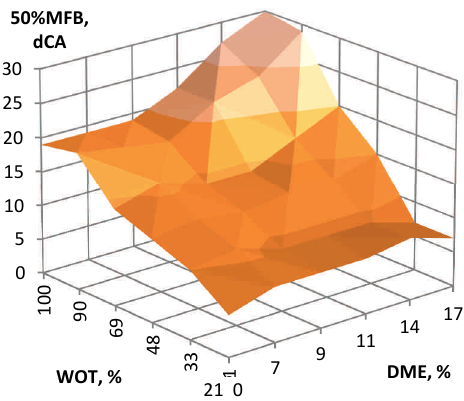
Fig. 12. A point of occurrence p max in working cycle, n = 2500 rpm